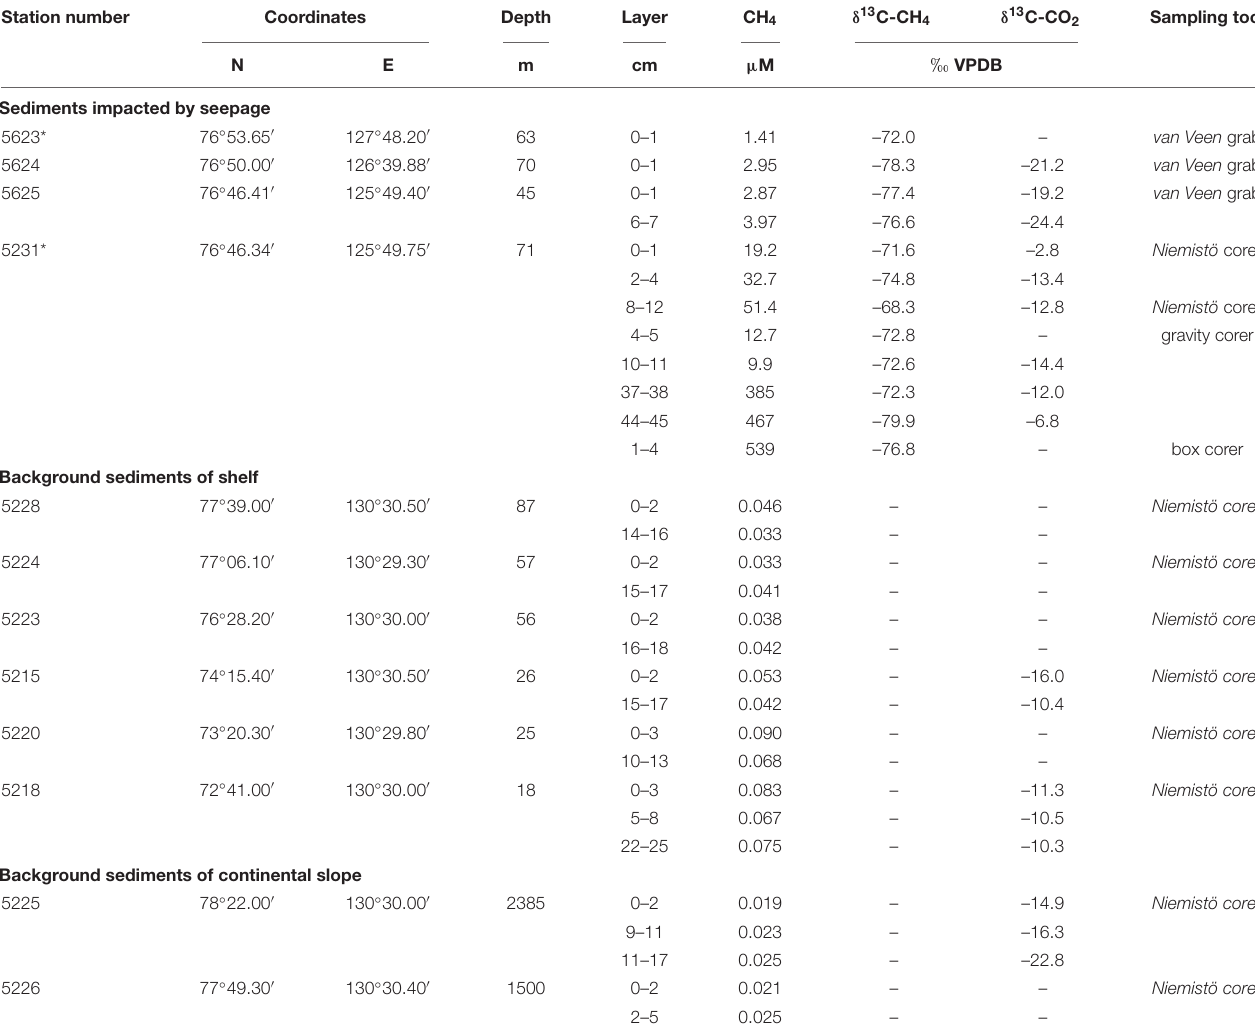
) of methane and carbon dioxide of the bottom sediments in the (cid:104)